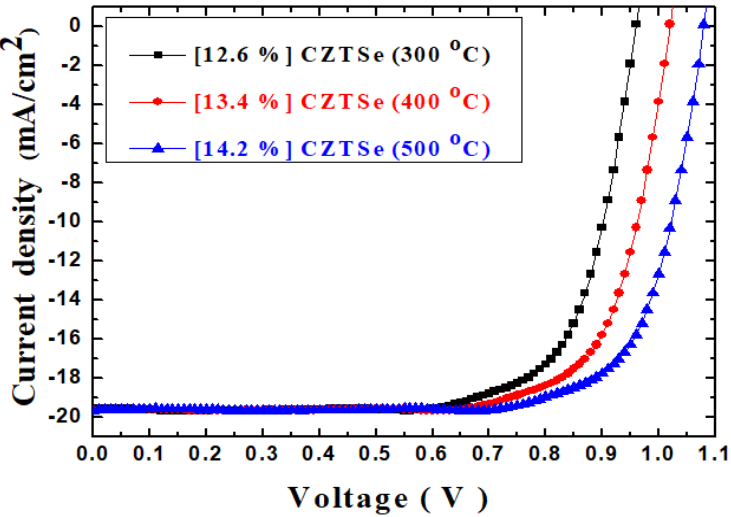
Figure 6. J–V curves for the Ag/C 60 /MAPbI 3 /CZTSe/Mo/FTO multilayered thin-film solar cells with various thermal annealing processes under 100 mW/cm 2 illumination (AM 1.5G).